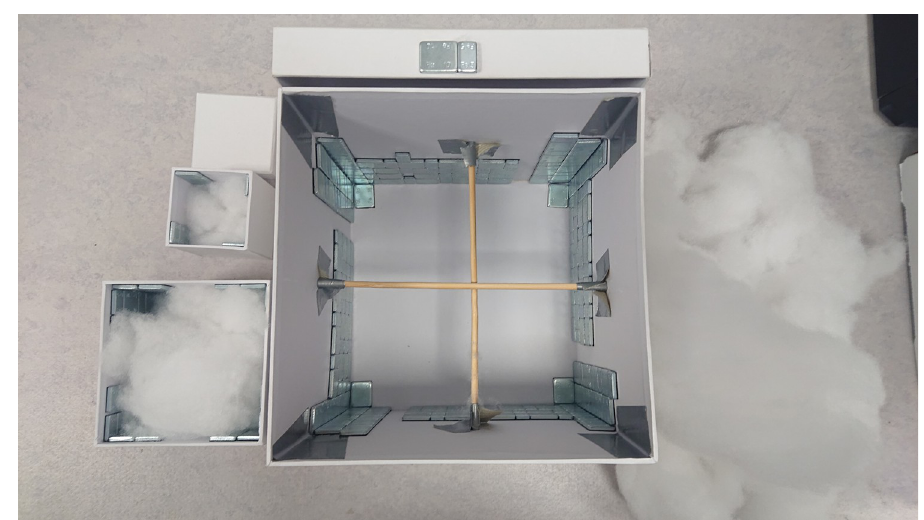
Fig 2. Photograph of the inside of the boxes and the added weights. The photograph illustrates examples of how the box weights were adjusted in each of the three different sizes used in our experiment. Single 10g and 5g weights can be seen on top of the lid at the top of the